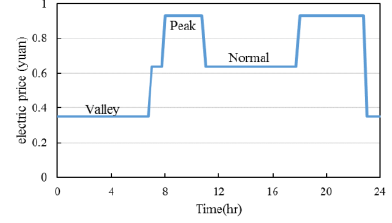
Fig. 2. Time-of-use price trend